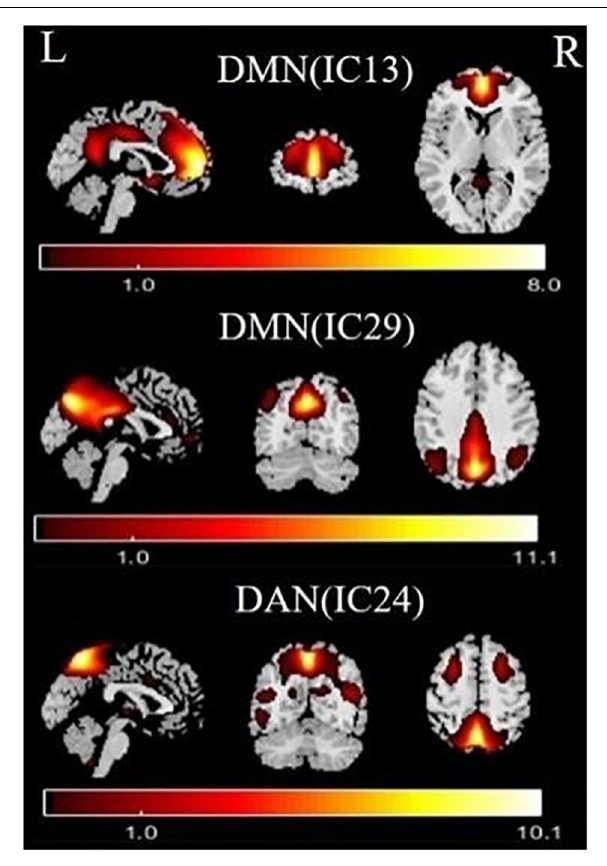
FIGURE 1 | Functional relevant resting-state networks (RSNs). The spatial maps of three independent components (ICs) were selected as the RSNs for further analysis. DMN, default mode network; DAN, dorsal attention network.